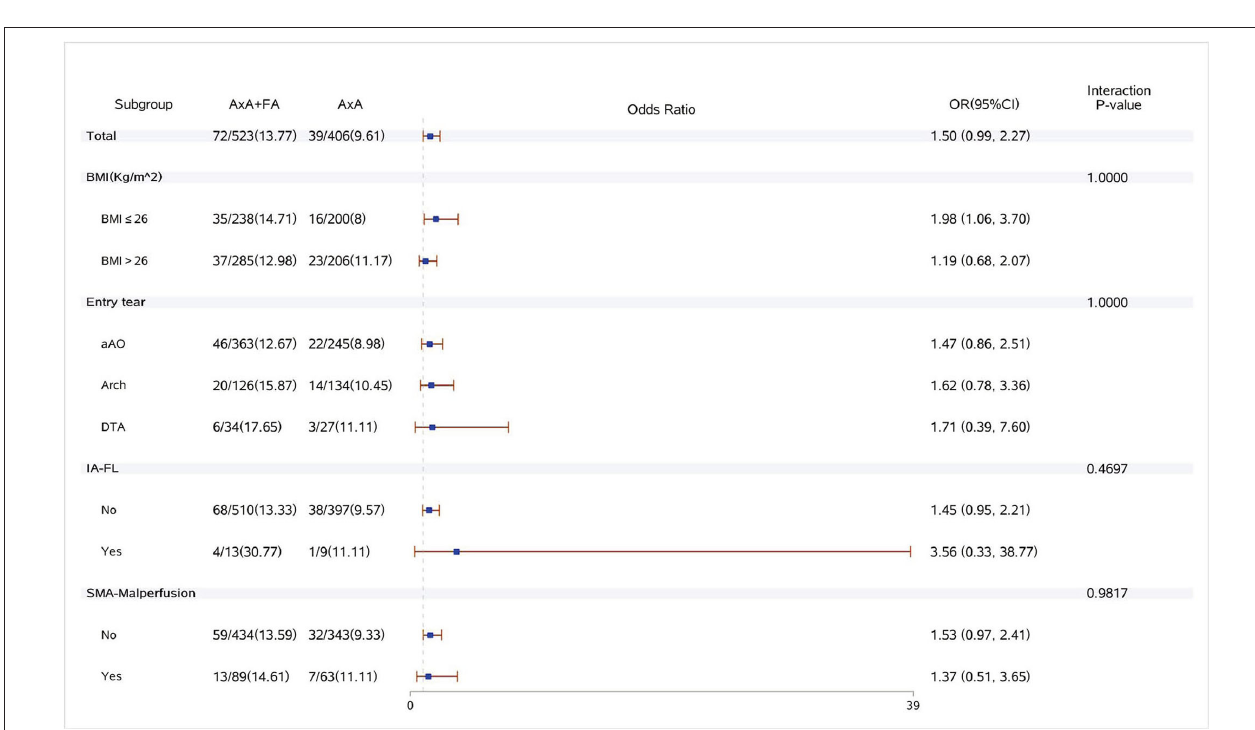
FIGURE 4 | Forest plot of dual arterial cannulation vs. axillary artery cannulation regarding acute renal failure requiring dialysis by subgroups. AXA + FA, axillary artery cannulation + femoral artery cannulation; AXA, axillary artery cannulation; IA-FL, innominate artery originating from false lumen; and SMA, superior mesenteric artery.